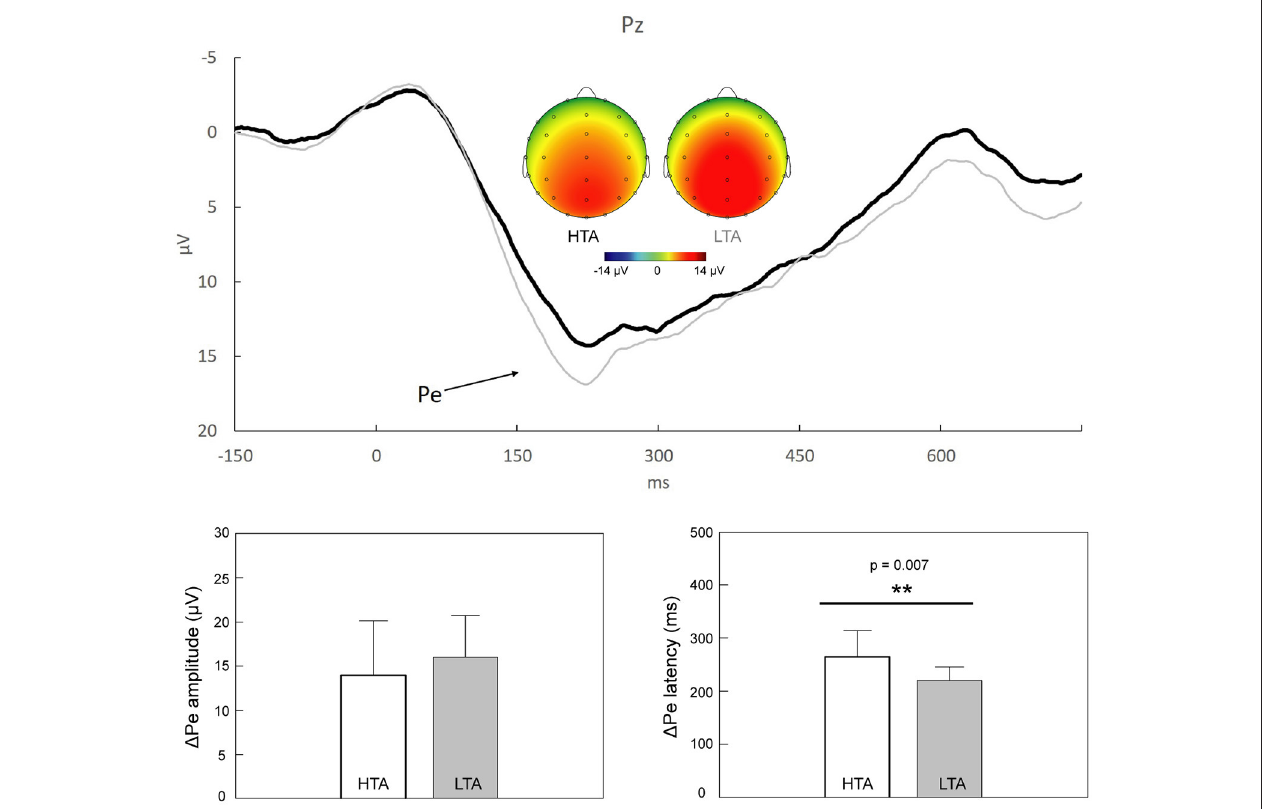
FIGURE 3 | Upper panel : Response-locked grand average 1 Pe (i.e., “error” minus “correct”) at Pz in individuals with high trait anxiety (HTA, black trace ) and those with low trait anxiety (LTA, gray trace ). The scalp topographies representing the peaks of 1 Pe in the HTA (174–274ms) and LTA (173–273ms) groups are also illustrated. Lower panel : Statistical results showed that, compared to individuals with LTA, those with HTA demonstrated a significant delay of 1 Pe latencies. ** p <